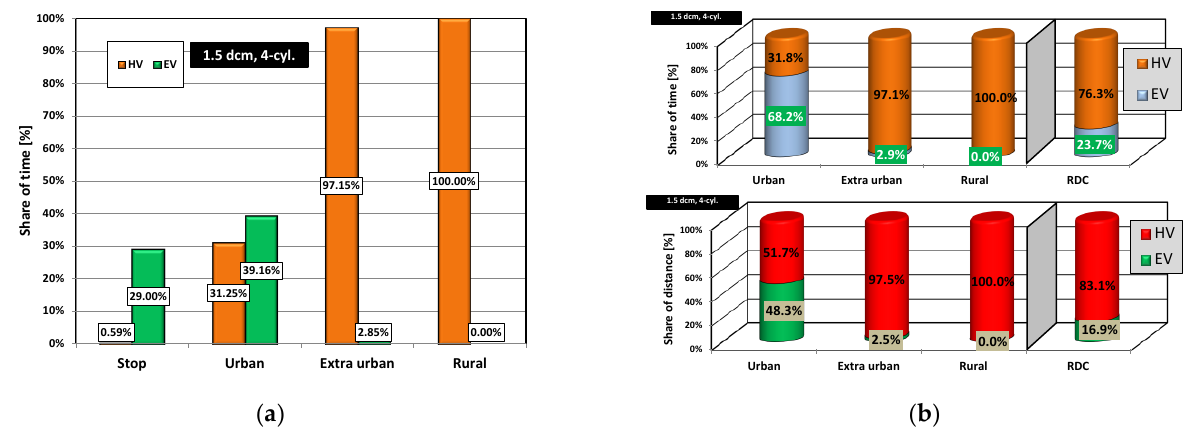
Figure 9. Operating conditions of the hybrid and electric powertrains in the new generation (3-cylinder engine): ( a ) the share of operation of the EV and the HV modes in individual portions of the test (vehicle stops included); ( b ) the share of the EV mode in relation to time and distance.